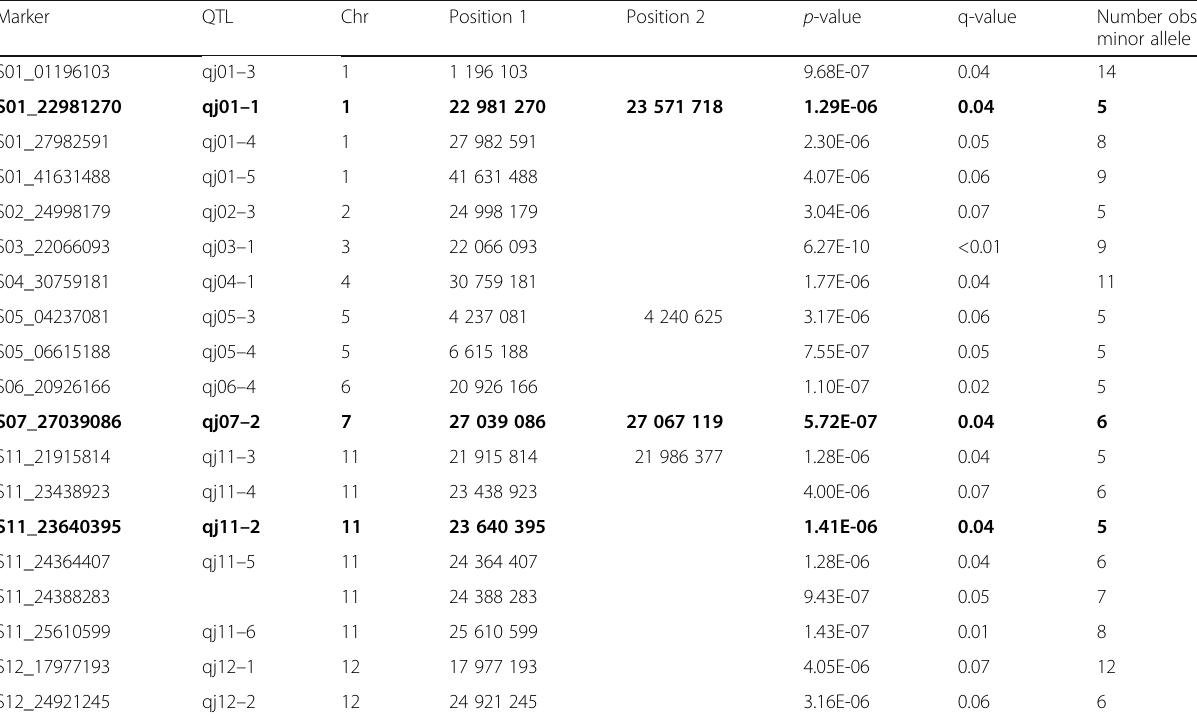
Table 6 Markers significant in the HDRA japonica